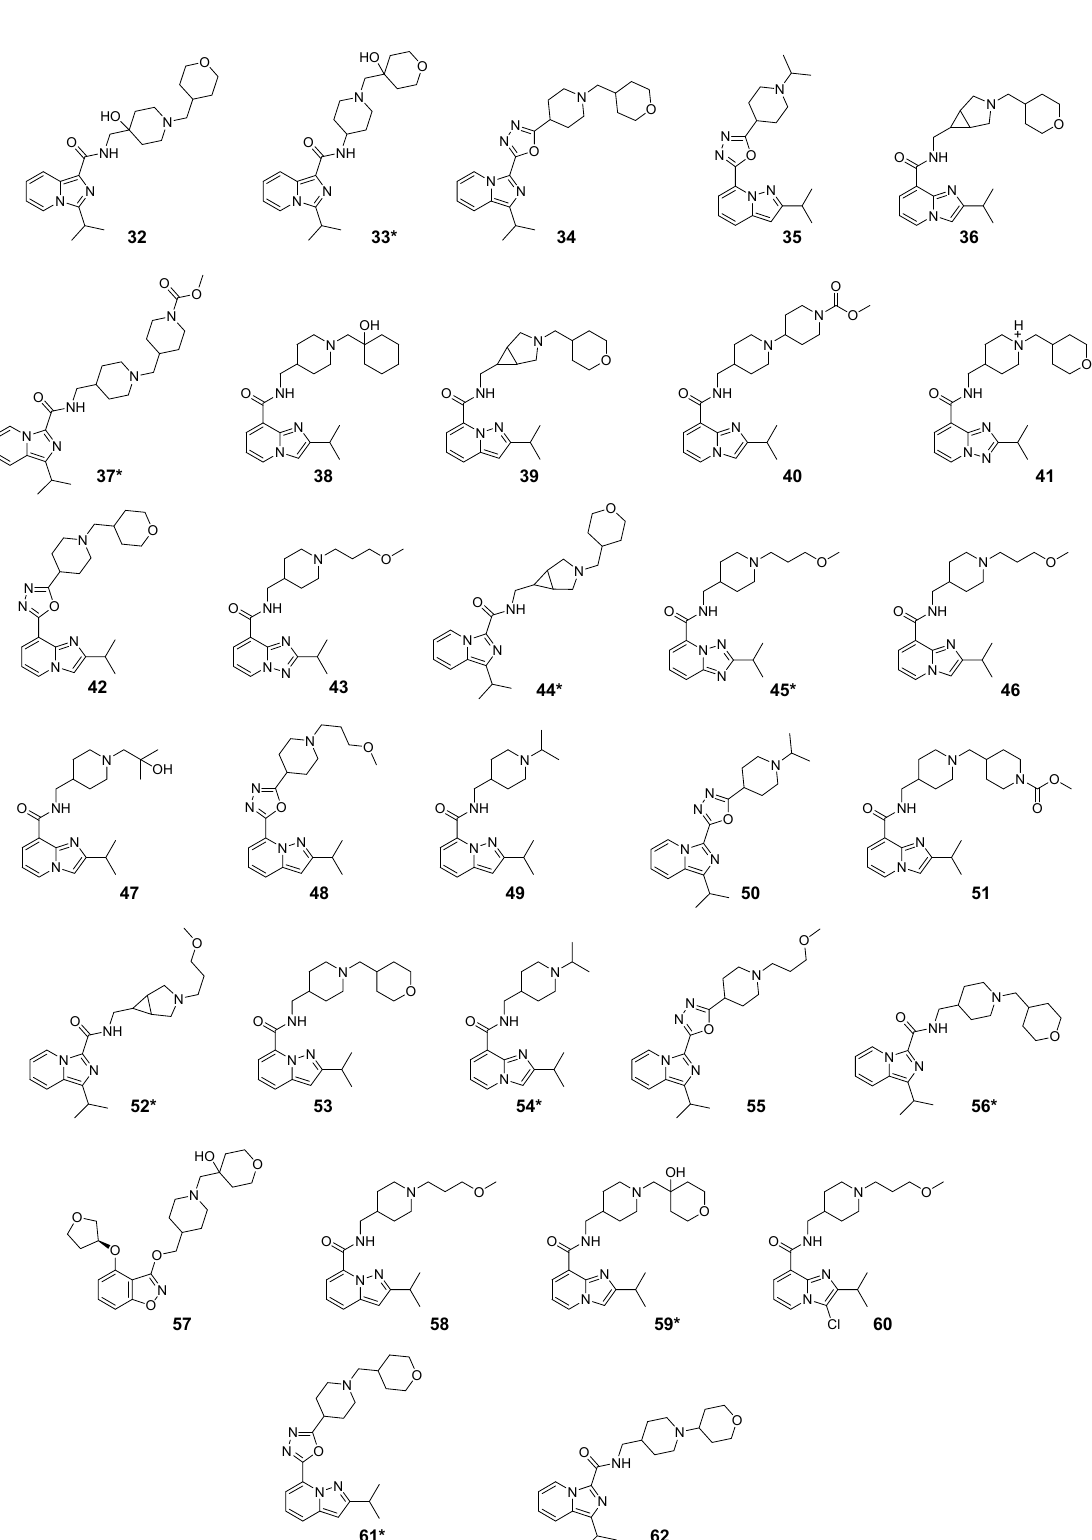
Figure 1. Dataset of 62 compounds. Structures with an asterisk (*) were used as a test dataset.